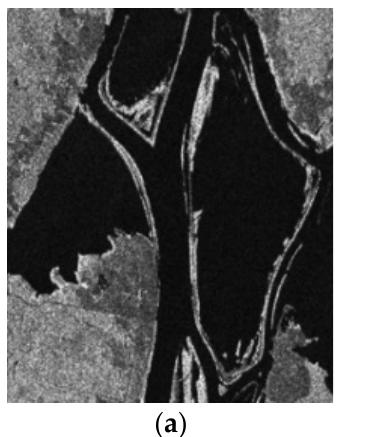
Figure 11. The Ottawa data: ( a ) May 1997 and ( b ) August 1997.